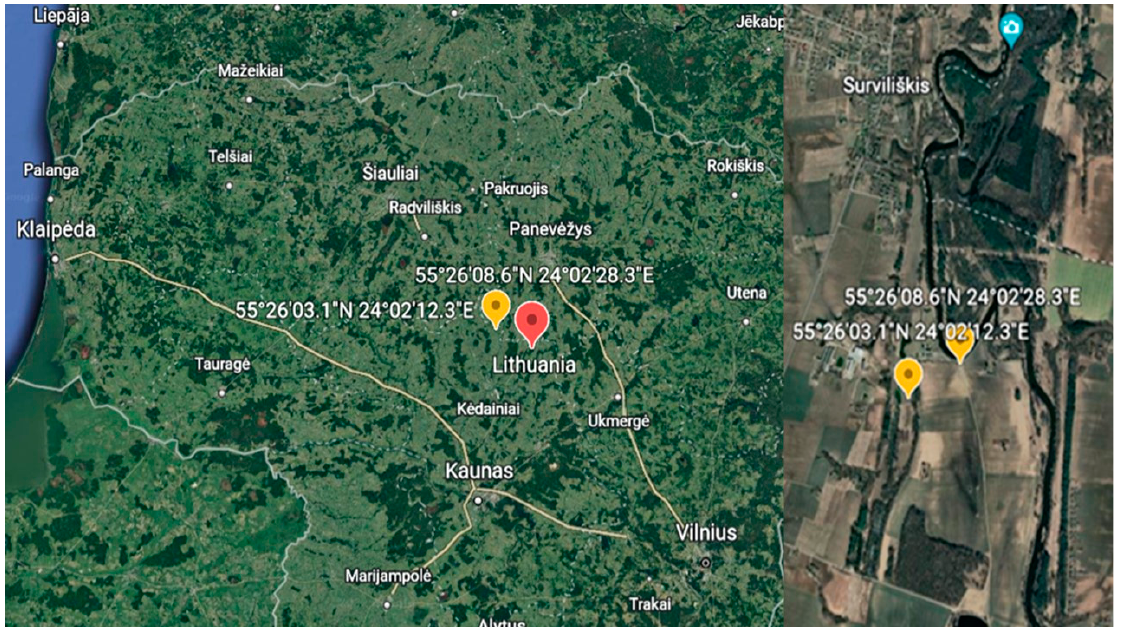
Figure 1. Experimental sites. The field experiments’ locations in Kedainiai District, the Fluvisol soil type. 55°26 ′ 08.60 ″ N or 24°02 ′ 28.28 ″ E—semi-natural grassland; 55°26 ′ 03.07 ″ N 24°02 ′ 12.26 ″ E—the crop rotation field.